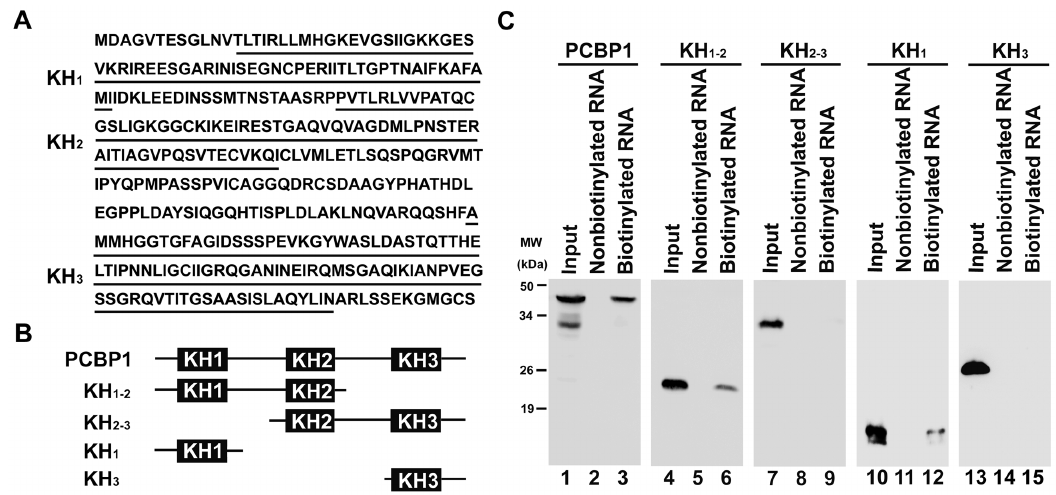
Figure 3. Analysis of the function domain of PCBP1 protein required for its binding to the 5 9 UTR of EV71 RNA. (A) The KH domains of full-length PCBP1 protein were predicted by PROSITE tools (http://prosite.expasy.org/). The amino acids of the three KH domains, KH1, KH2, and KH3, were underlined. (B) Based on the sequences of PCBP1 protein and its predicted domains, five plasmids expressing the full-length PCBP1 or truncated PCBP1 proteins were constructed, in which the KH3 was deleted (KH 1-2 ), the KH1 was deleted (KH 2-3 ), both KH2 and KH3 were deleted (KH 1 ), or both KH1 and KH2 were deleted (KH 3 ), respectively. (C) For the RNA-protein binding assay, HeLa cells were transfected with plasmids coding the Flag- tagged full-length PCBP1 (lanes 1-3) or the Flag-tagged truncated proteins, PCBP1-KH 1-2 (lanes 4–6), PCBP1-KH 2-3 (lanes 7–9), PCBP1-KH 1 (lanes 10– 12), and PCBP1-KH 3 (lanes 13–15), respectively. For the pull-down assay, cell extracts were prepared and mixed with nonbiotinylated EV71 5 9 UTR RNA (lanes 2, 5, 8, 11, and 14) or biotinylated EV71 5 9 UTR RNA (lanes 3, 6, 9, 12, and 15), respectively. The complexes were boiled and dissolved and PCBP1 protein was determined by western blot analysis using anti-Flag antibody (lanes 2, 3, 5, 6, 8, 9, 11, 12, 14, and 15). The inputs were cell extracts without pull-down assay (lanes 1, 4, 7, 10, and